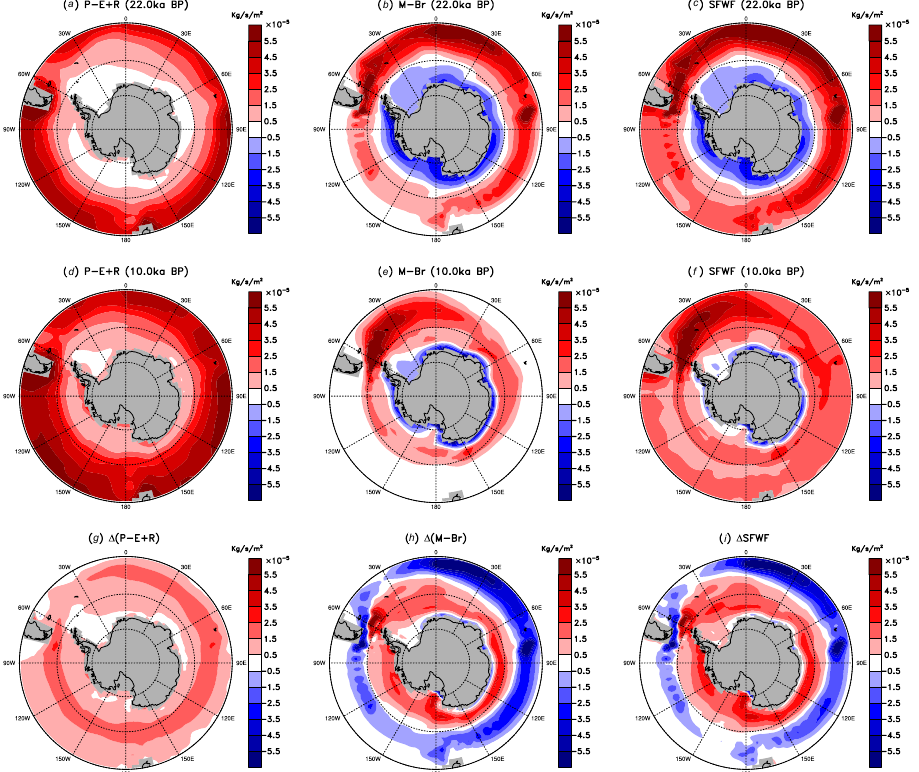
Figure 9. (Top row ( a – c )) Surface freshwater fluxes (shading in 10 − 5 kg/s/m 2 ) from ( a ) precipitation, evaporation and runoff and ( b ) sea ice melting and brine rejection as well as ( c ) the total surface freshwater flux in the Southern Ocean at 22 ka BP. (middle row ( d – f )) The same as the top row but for 10 ka BP. (bottom row ( g – i )) Differences between the fluxes in the middle and top rows (fluxes at 10 ka BP minus fluxes at 22 ka